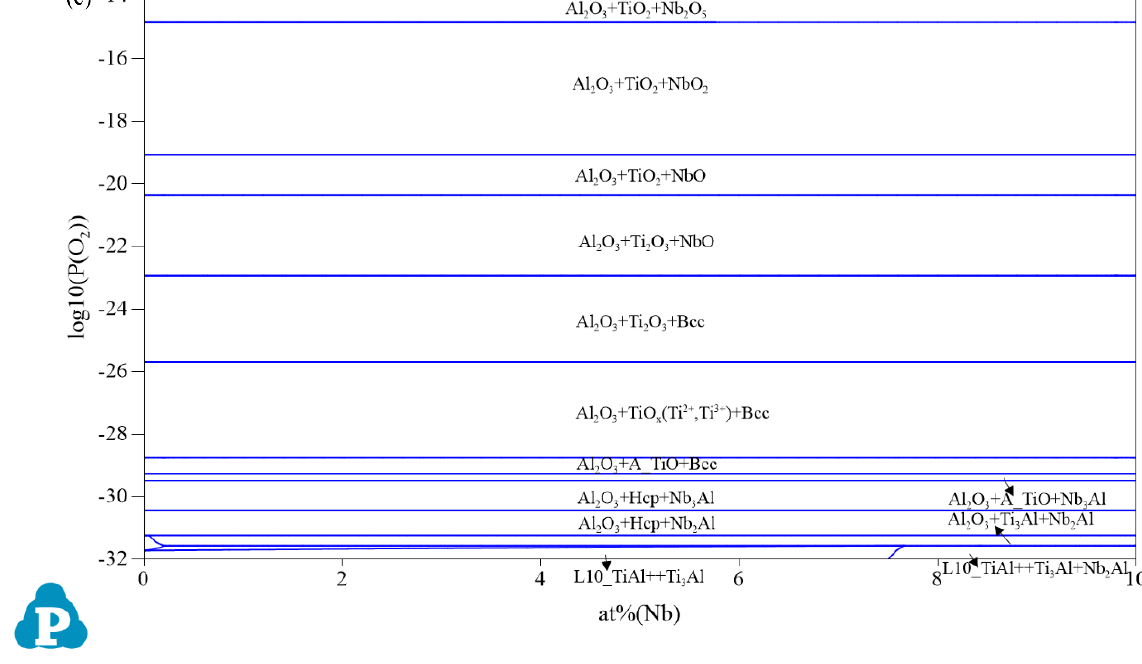
Figure 2. Initial oxidation products of Ti-45Al-xNb alloy at 700 °C ( a ), 800 °C ( b ), and 900 °C ( c ).